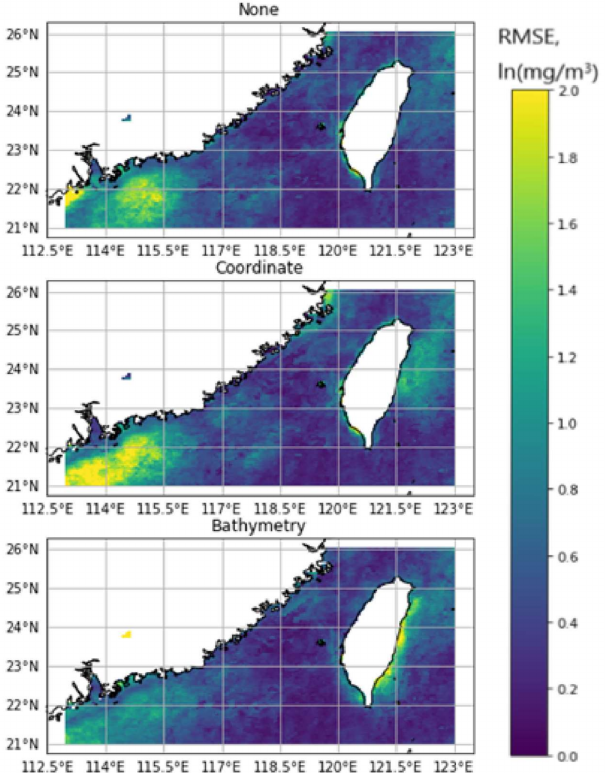
Figure 11. RMSE spatial distribution of the three models for the test